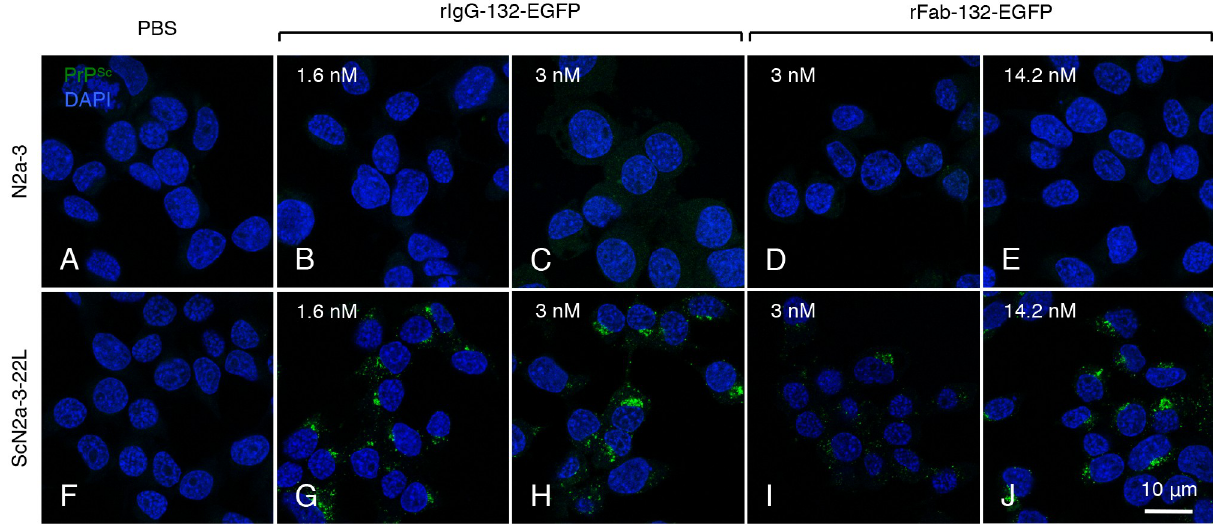
Fig 4. PrP Sc -specific detection by direct immunofluorescence staining. Prion-uninfected N2a-3 cells (A–E) and prion 22L strain-infected Na-3 cells (ScN2a-3-22L) (F–J) cells were directly stained using rIgG-132-EGFP (B, C, G, and H) and rFab-132-EGFP (D, E, I, and J) at the indicated concentrations equivalent to the Fab portions. The leftmost images (A, F) show negative controls for EGFP fusion proteins. Cell nuclei were stained with DAPI (blue).